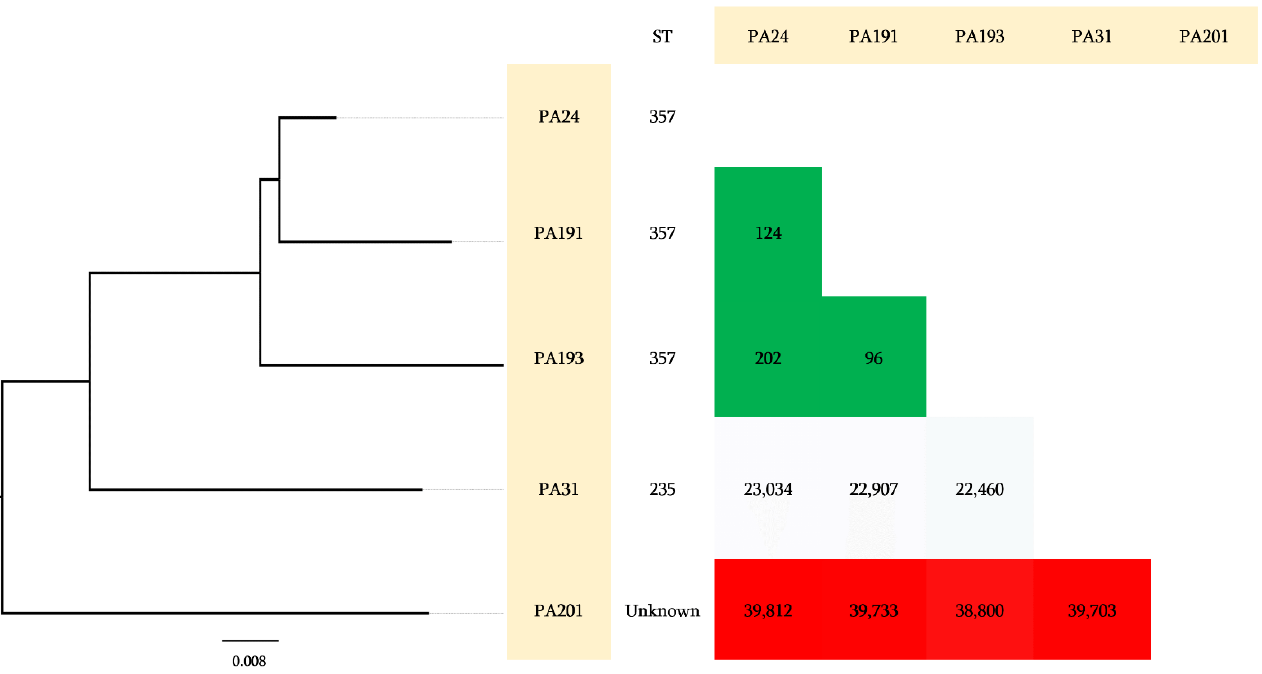
Figure 4. Genomic characterization of P. aeruginosa isolates and the pairwise comparison of the ge- nomic gSNPs.